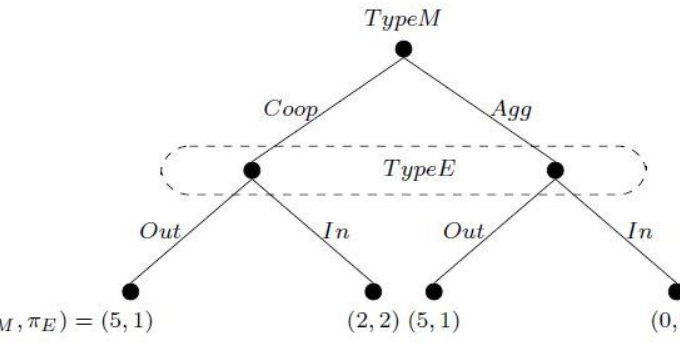
Figure 4. The One-Stage Game In a